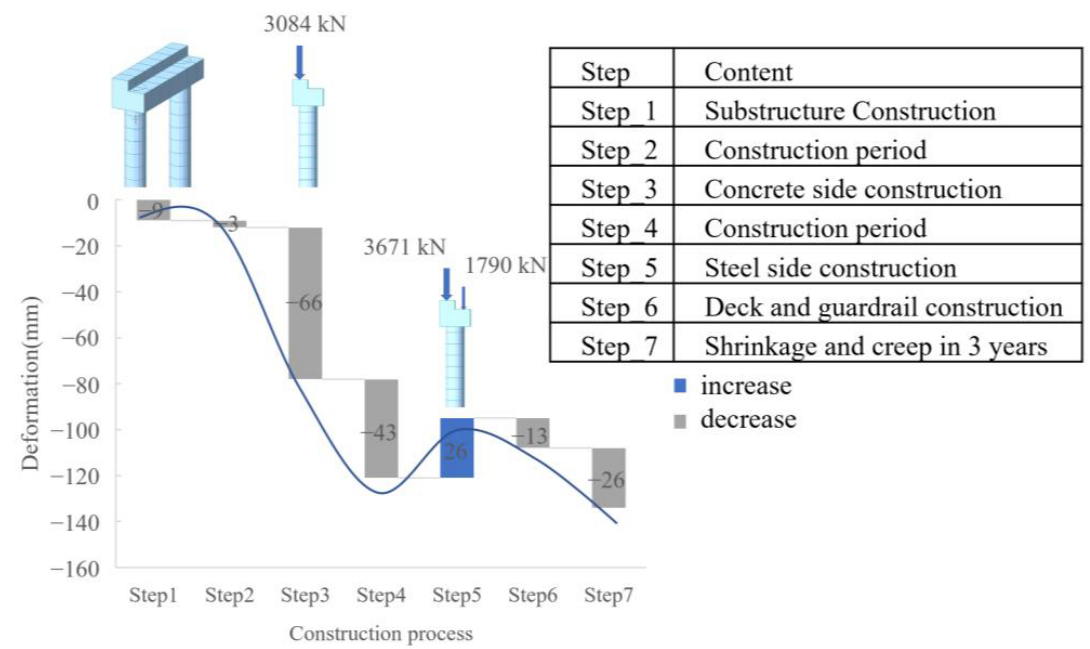
Figure 14. Waterfall plot of the longitudinal inclination on Pier P30. The longitudinal inclination processes of Piers P33 and P35 are shown in Figure 15.